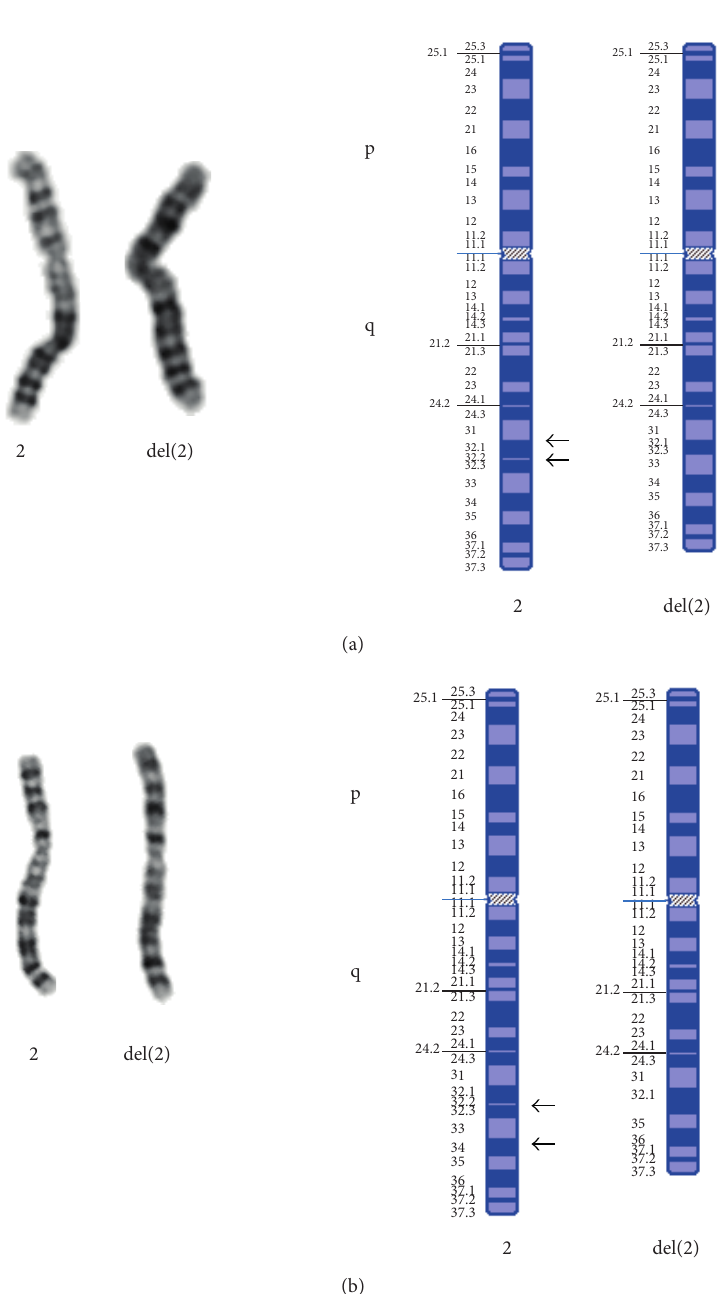
derived (data not